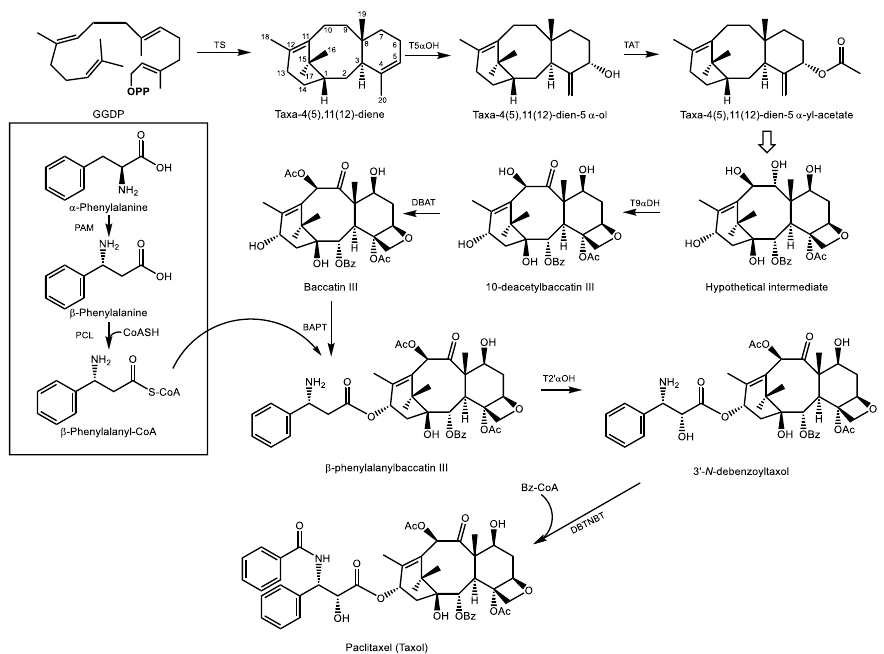
Figure 8. Simplified pathway for the biosynthesis of paclitaxel (taxol) in T. brevifolia (pacific yew).